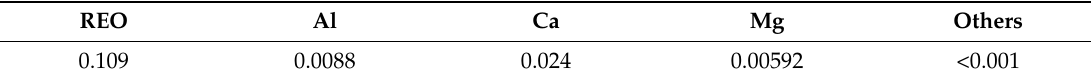
Table 3. The exchangeable phase of rare earth ore (REO) (wt %).